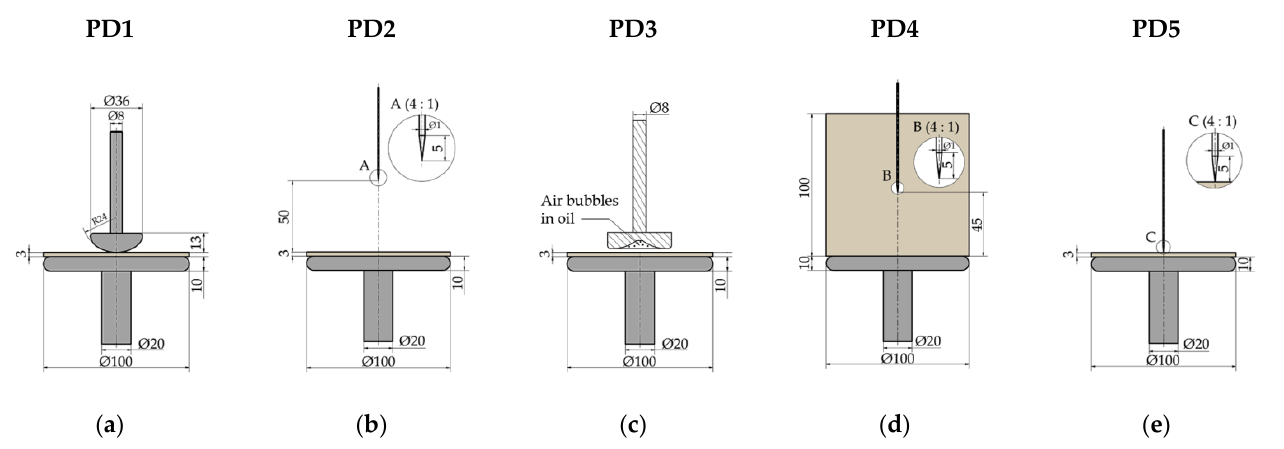
Figure 1. Schematic diagrams of electrode systems for generating partial discharges in oil-paper insulation: ( a ) Partial discharges in oil gap. ( b ) Partial discharges in oil. ( c ) Partial discharges in air bubbles in oil. ( d ) Surface discharges on pressboard sample in oil with a negligibly small normal component of the electric field. ( e ) Creeping discharges (surface discharges on a pressboard sample in oil with significant normal component of electric